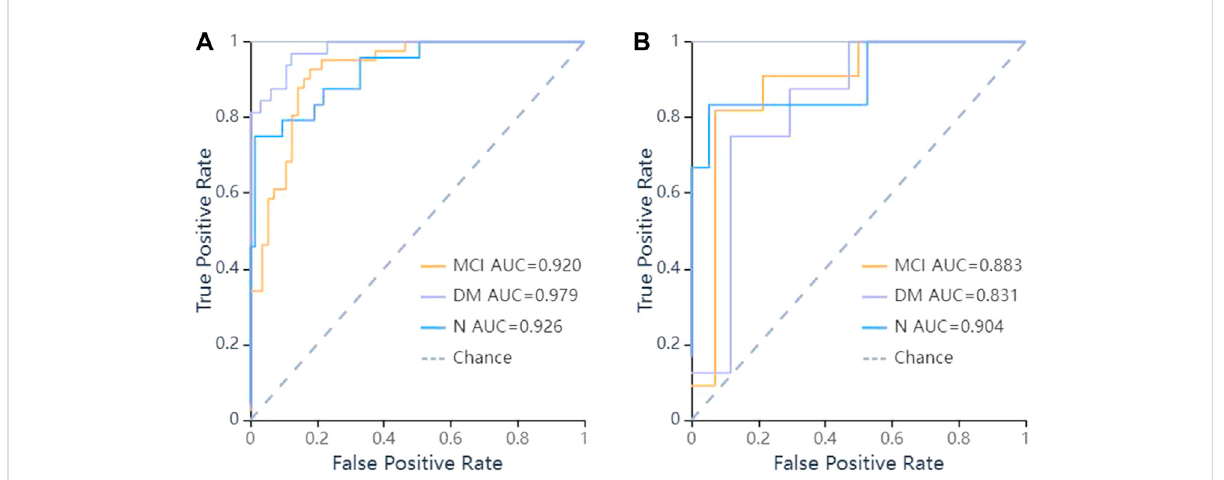
FIGURE 5 ROC curves of LR methods to classi fi cation. (A) ROC curve of training set, the AUC were 0.979 in DM (sensitivity and speci fi city were 0.84 and {"MCI ” : 0.8, “ DM ” : 0.97, “ N": 0.99}), 0.92 in MCI (sensitivity and speci fi city were 0.93 and {"MCI ” : 0.8, “ DM ” : 0.97, “ N": 0.99}), 0.926 in N (sensitivity and speci fi city were 0.75 and {"MCI ” : 0.8, “ DM ” : 0.97, “ N": 0.99}) respectively; (B) ROC curve of validation set, the AUC were 0.831 in DM (sensitivity and speci fi citywere0.88and{"MCI ” :0.93, “ DM ” :0.71, “ N":0.95}),0.883inMCI(sensitivityandspeci fi citywere0.64and{"MCI ” :0.93, “ DM ” :0.71, “ N": 0.95}), 0.904 in N (sensitivity and speci fi city were 0.67 and {"MCI ” : 0.93, “ DM ” : 0.71, “ N": 0.95}) respectively.